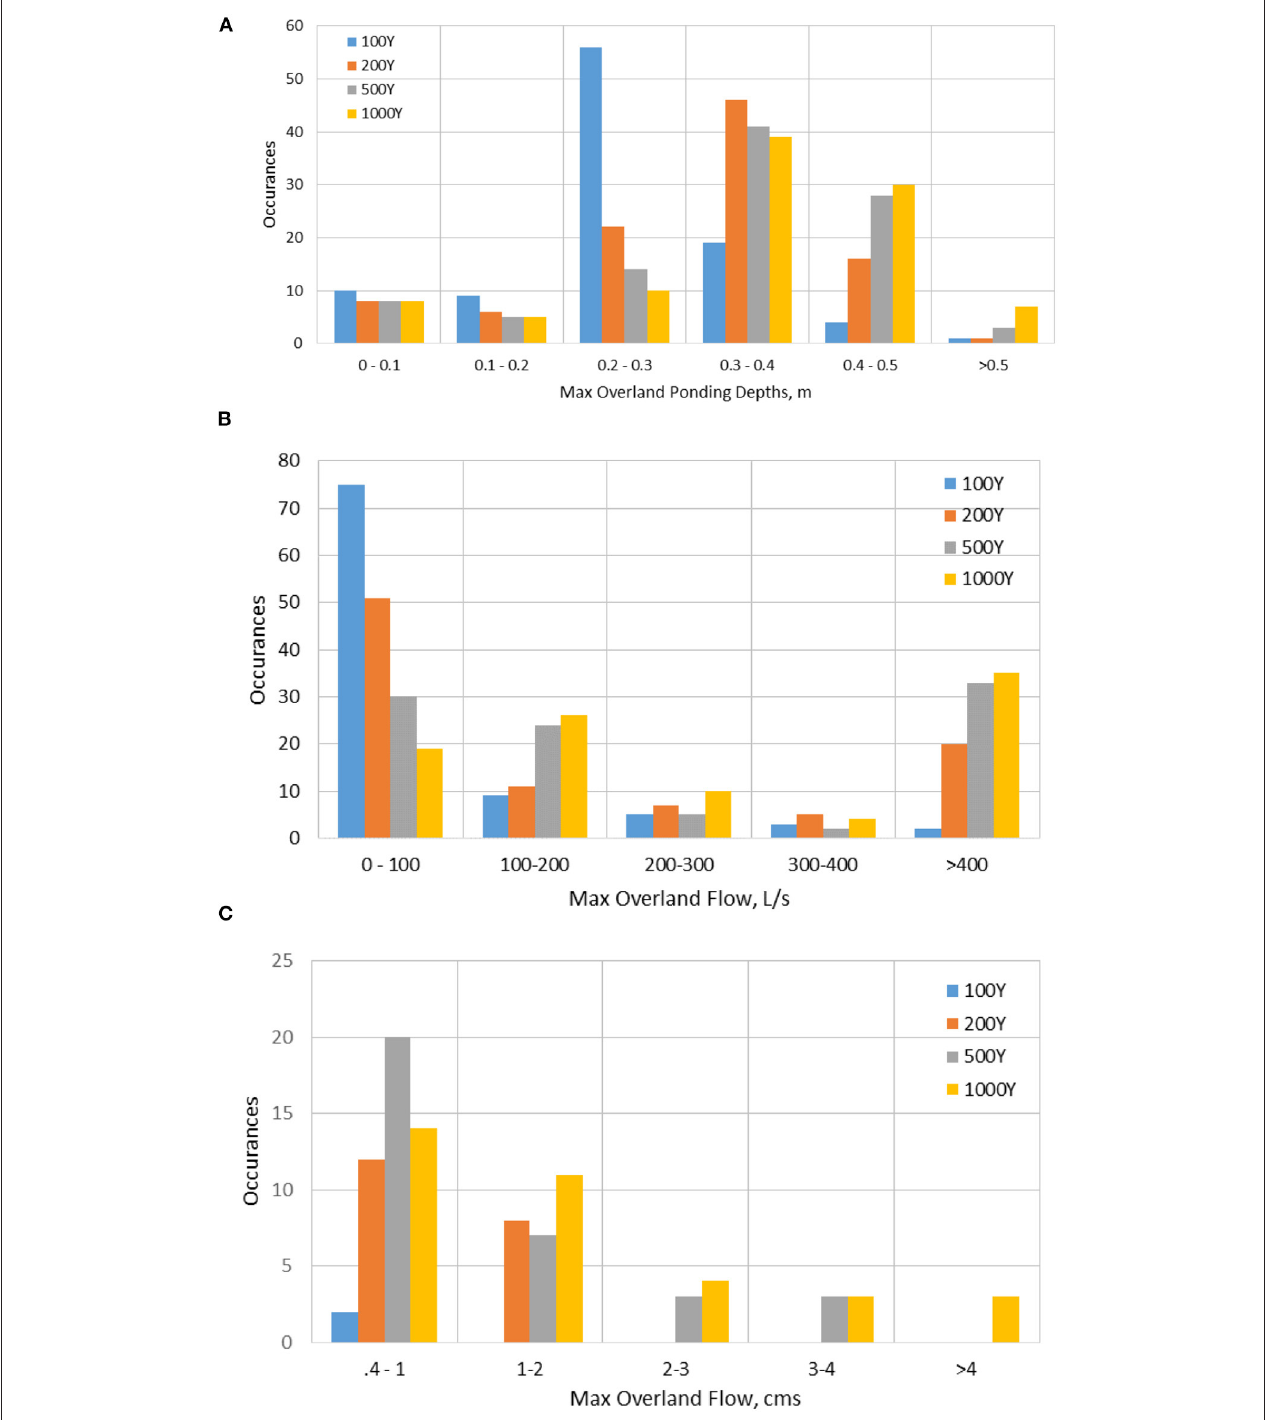
FIGURE 8 | (A) Depth of Ponding in Sags and (B,C) Peak Flow Rate—Overland Flow.